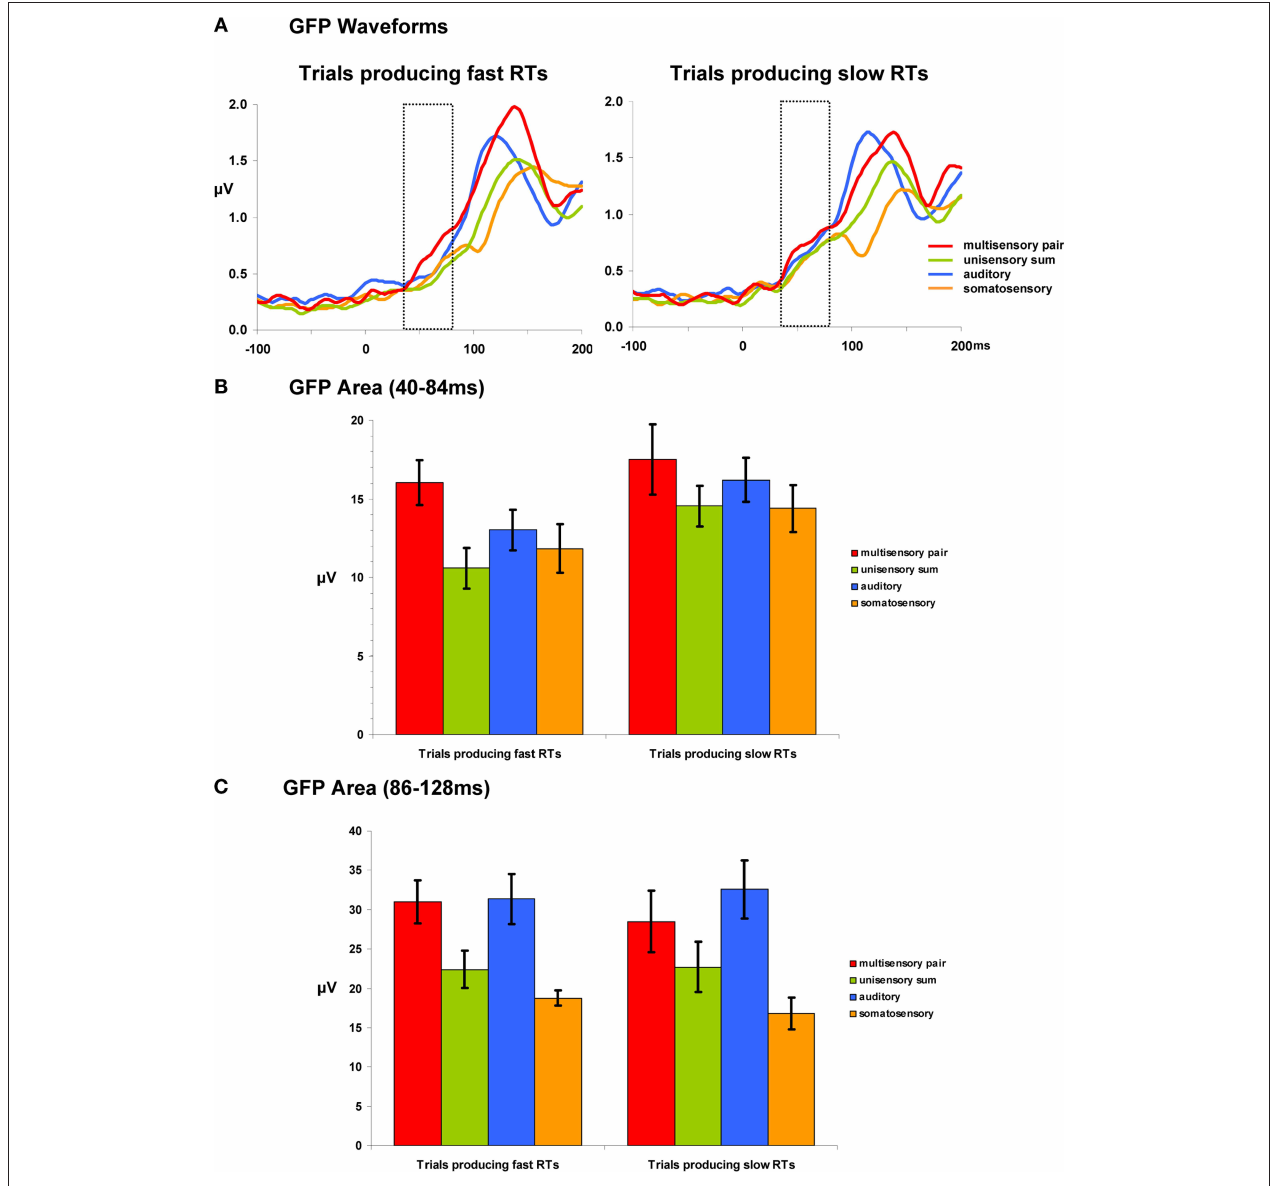
FIGURE 3 | Global fi eld power (GFP) waveforms and analyses. (A) group-averaged GFP waveforms are displayed for each condition and are also separated according to later RT speed. The dotted insets indicate the 40–84 ms post-stimulus interval over which area measures were calculated. (B) Mean (SEM shown) GFP area measurements over the 40–84 ms post-stimulus interval. (C) Mean (SEM shown) GFP area measurements over the 86–128 ms post-stimulus